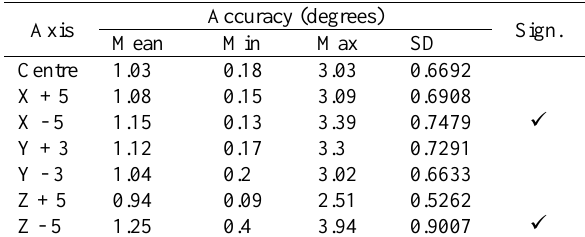
Table 4. Accuracy as affected by head